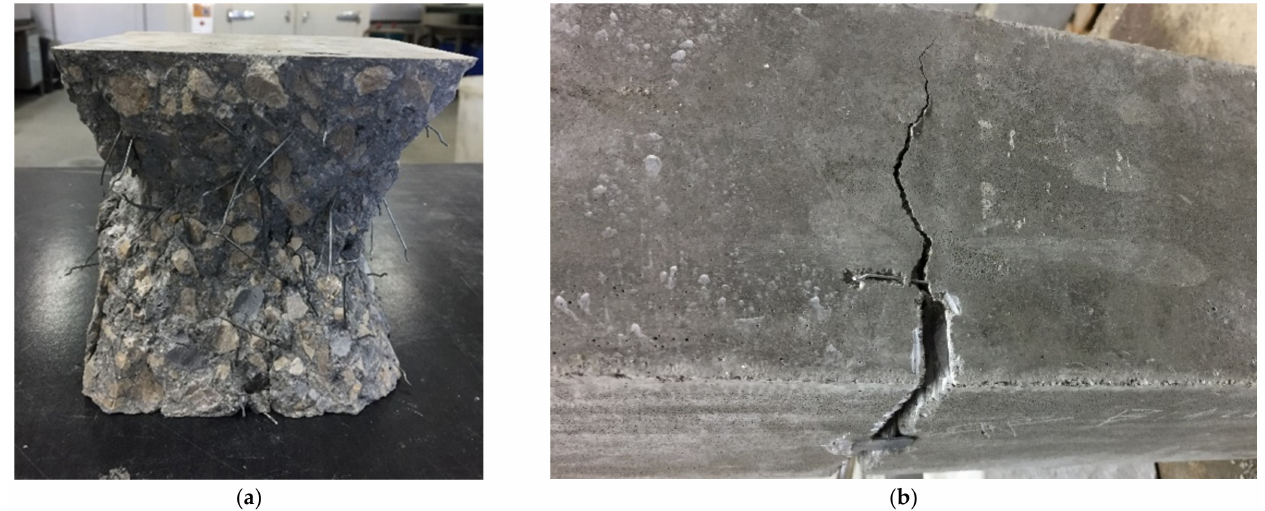
Figure 10. Specimens after compressive test ( a ) and flexural test ( b